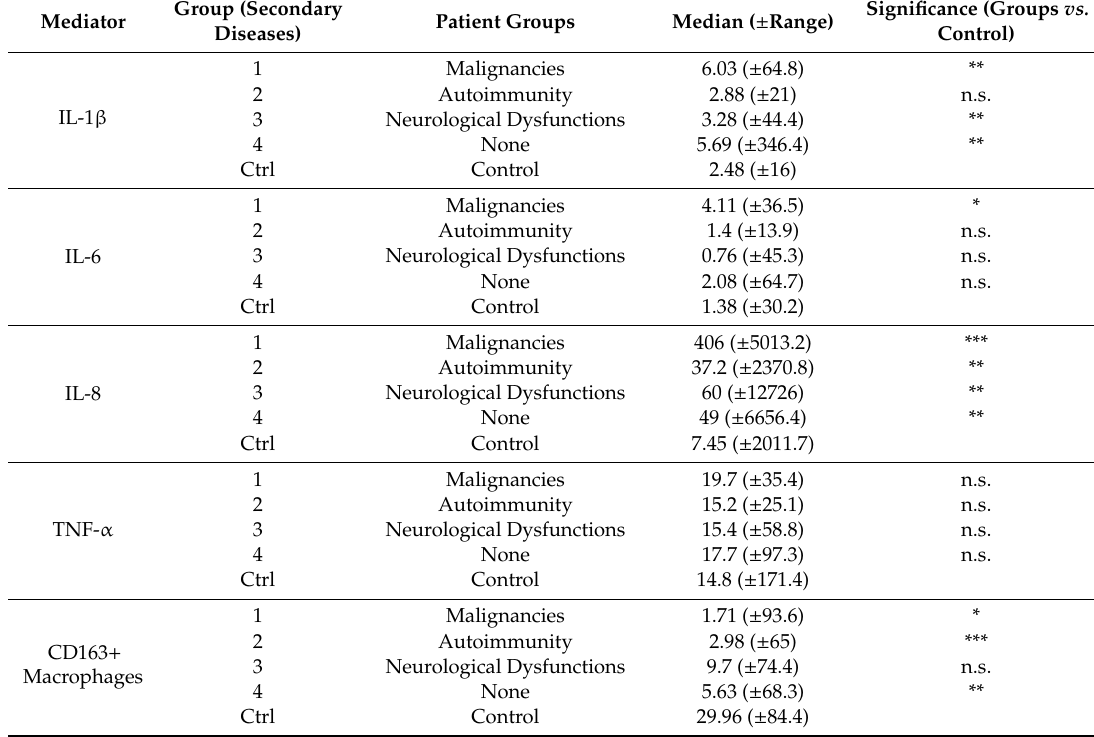
Table 2. Cytokine expression or percentages of CD163 positive monocytes / macrophages related to secondary diseases (1–4), as compared to healthy controls. Median values of IL-1 β , IL-6, IL-8, and TNF- α (pg / mL), medians of CD163 + macrophages (% positive). p -values > 0.05 (n.s.), ≤ 0.05 (*), ≤ 0.01